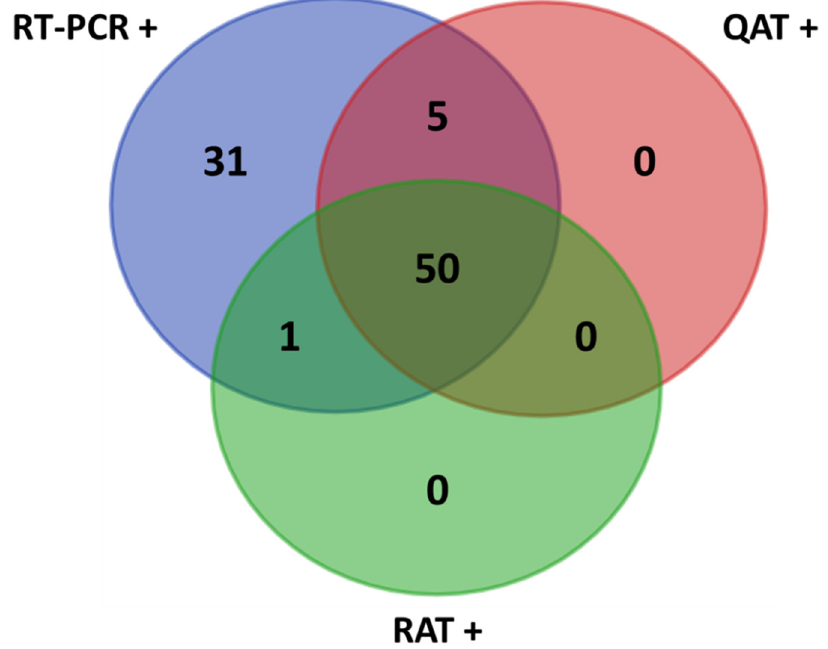
Figure 1. Venn diagram of the results. +: positive samples; QAT: quantitative antigen test; RAT: rapid antigen test; RT-PCR: reverse-transcription polymerase chain reaction.